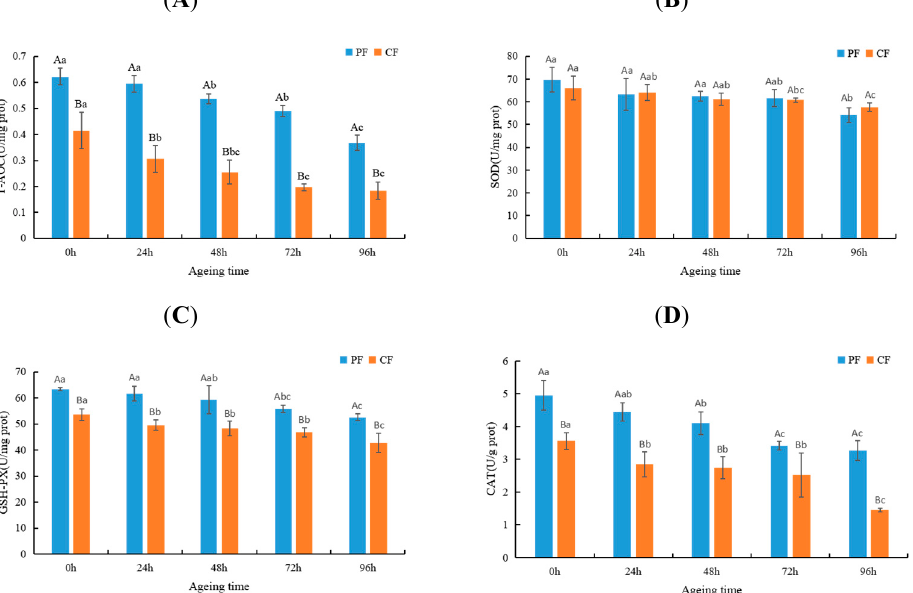
Figure 1. Changes in T-AOC ( A ), SOD activity ( B ), GSH-PX activity ( C ), and CAT activity ( D ) in LT muscle of the PF and CF during postmortem aging. The capital letters indicate significant differences in feeding regimes ( p < 0.05), and the lowercase letters represent significant differences at different time points during postmortem aging ( p < 0.05). Table 2. Effects of different feeding regimes and postmortem aging times on the quality attributes in the LT muscles of